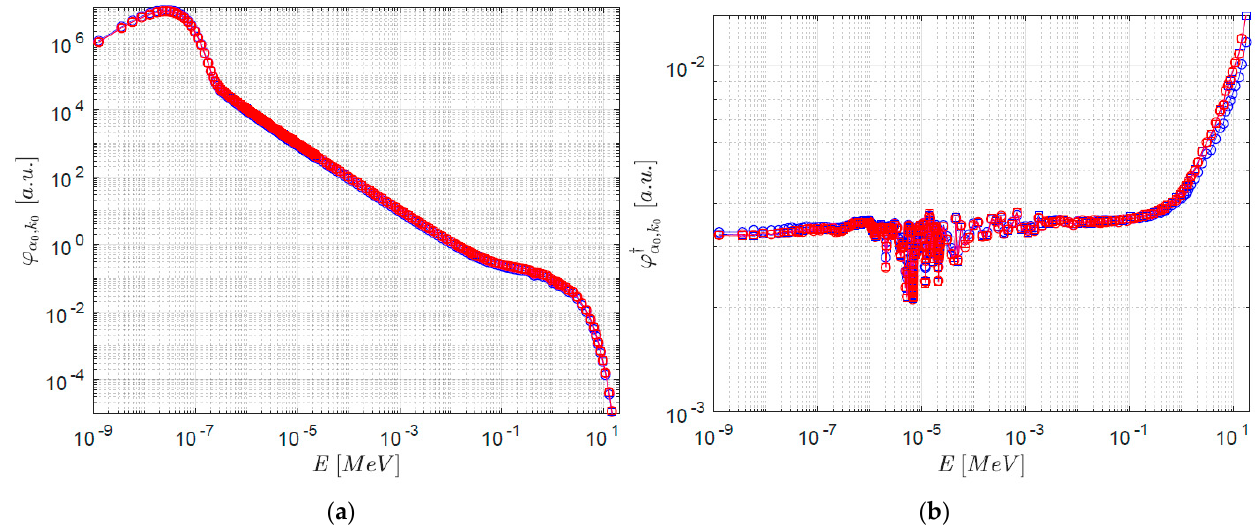
Figure 5. Problem III, sub-critical configuration, direct ( a ) and adjoint ( b ) fundamental distributions according to the α - (blue) and k - (red) eigenvalue formulations, with (squares) and without (circles) delayed contributions.